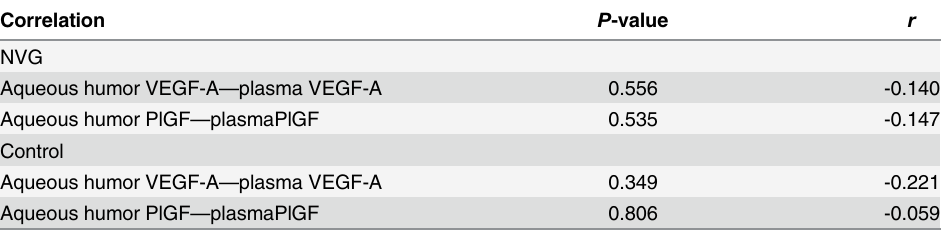
Table 4. Correlations of aqueous humor and plasma VEGF-A and PlGF levels in study groups. Correlation